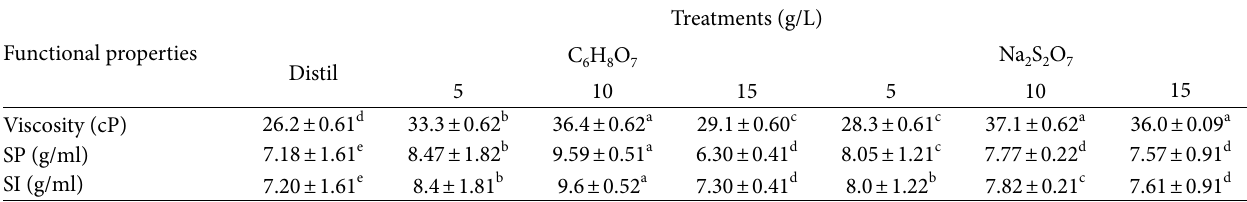
Table 3: Viscosity, swelling power and solubility index of NSP flour.